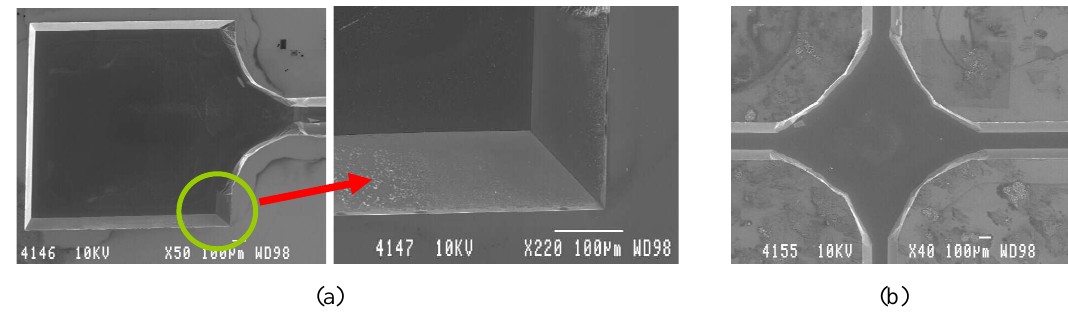
Figure 5: (a) Smooth sidewalls of the inlet port produced by the anisotropic etching (b) Mixing zone of the microfluidic channel.